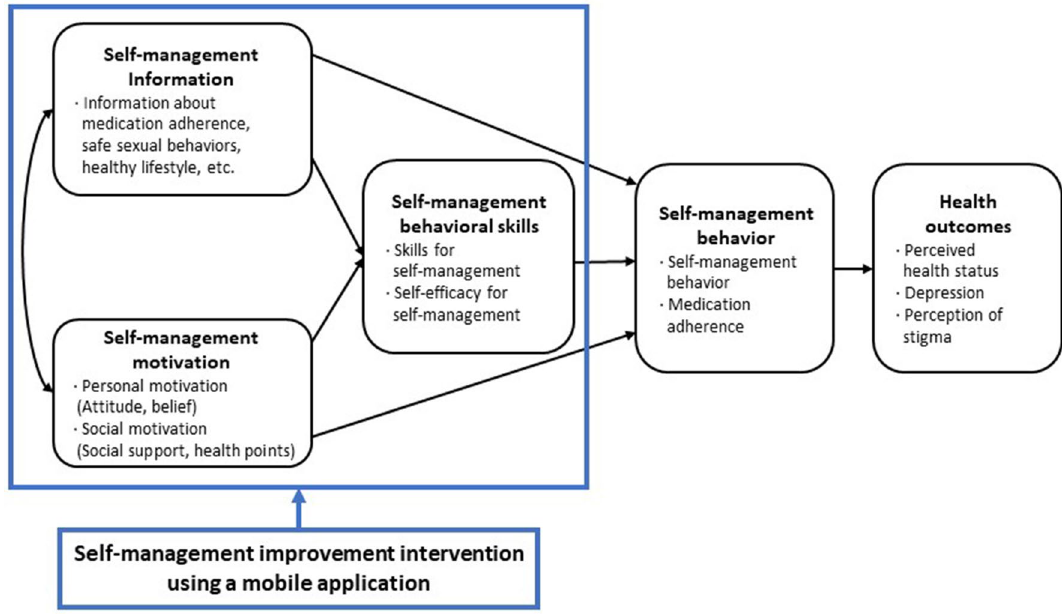
Figure 1. Conceptual framework of the self-management program using a mobile application.